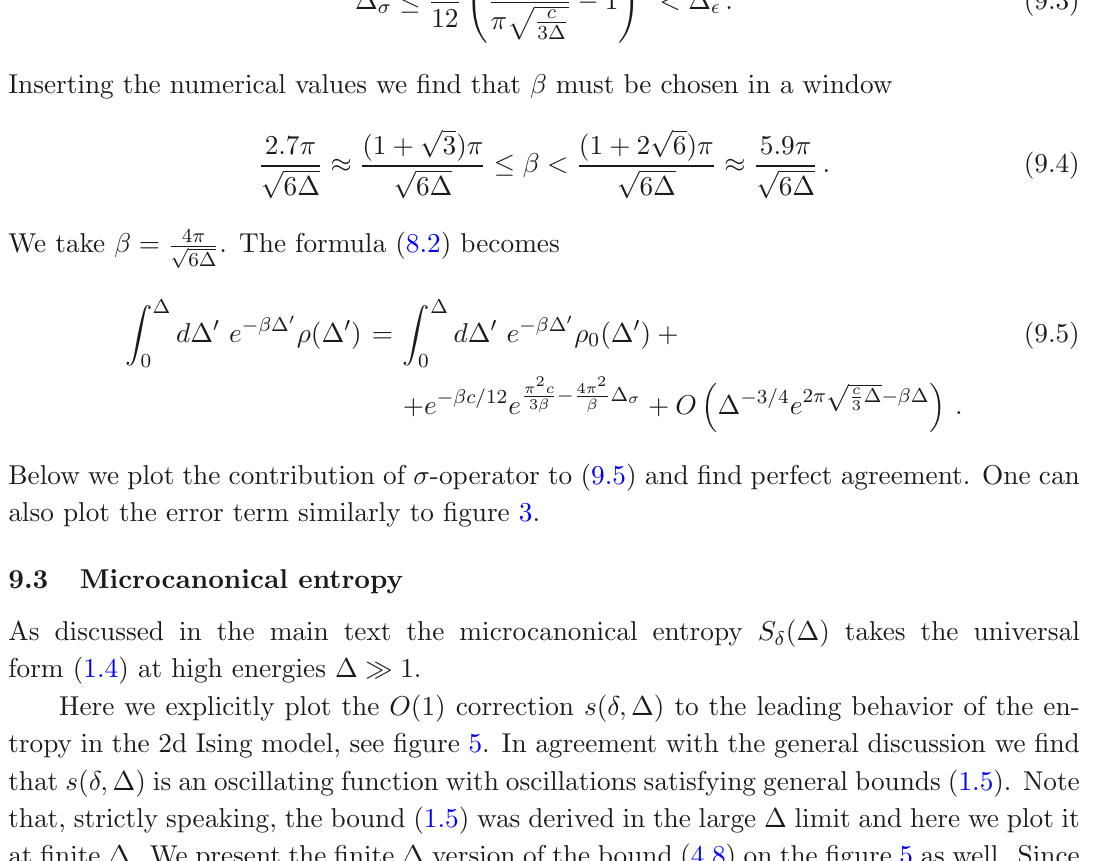
∆ d ∆ ′ e − β ∆ ′ δρ (∆ ′ ) (blue) and e − βc/ 12 e π 0 R